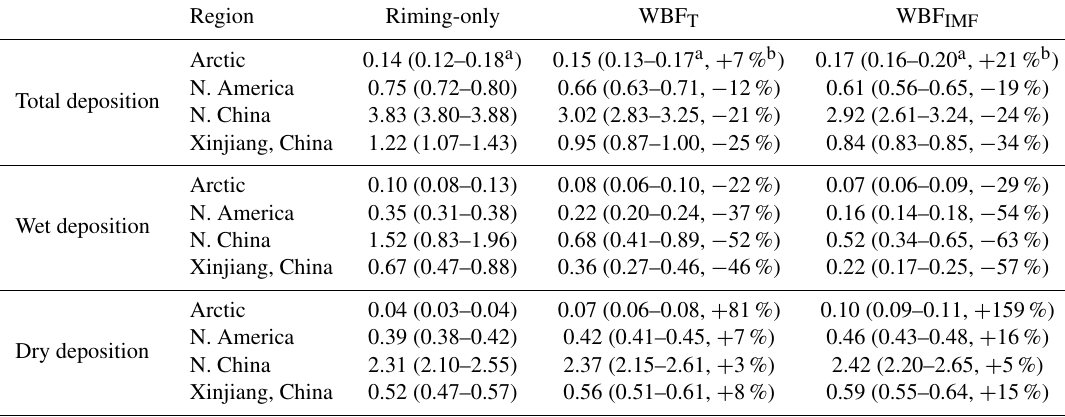
Table 5. GEOS-Chem-simulated BC deposition fluxes (mgm − 2 month − 1 ) in the Arctic (September–April), North America (November– February), northern China (November–February) and western China (November–February), averaged for 2007–2009.